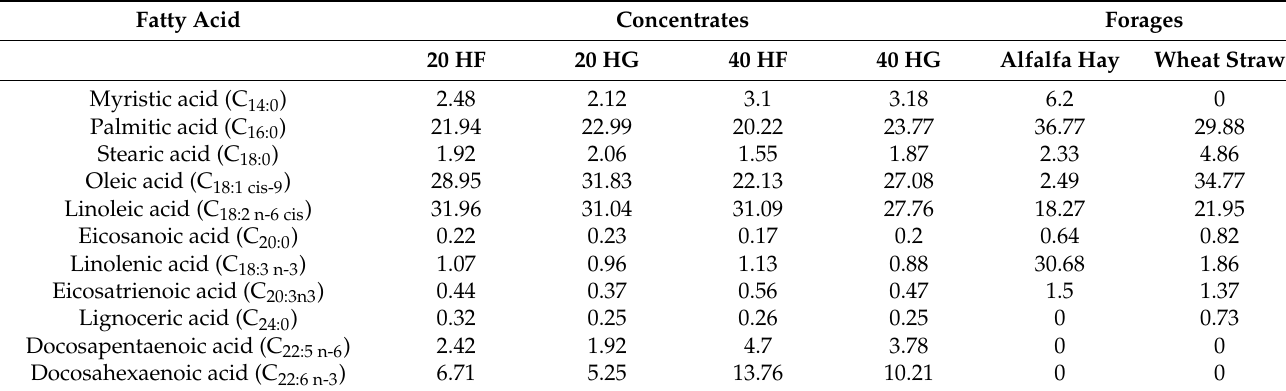
Table 2. Alfalfa hay, wheat straw and concentrates fatty acid profile (FA) (% of total FA). Fatty Acid Concentrates Forages 20 HF 40 HG Alfalfa Hay Wheat